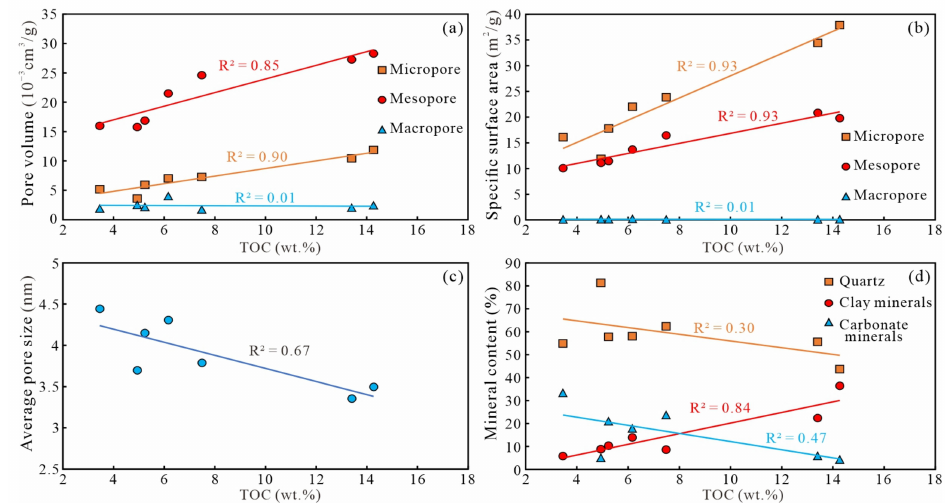
Figure 14. Correlations between pore structure parameters, mineral contents, and organic matter contents in the Dalong Formation shales: ( a ) Pore volume, ( b ) Pore specific surface area (both separated by pore size class), ( c ) Average pore size, ( d ) Mineral content vs. TOC content.